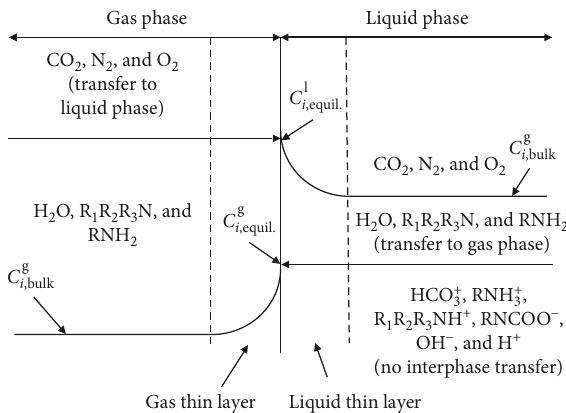
Figure 2: Concentration gradients at the vapor-liquid interphase. Table 1: List of chemical species participating in the reaction scheme.